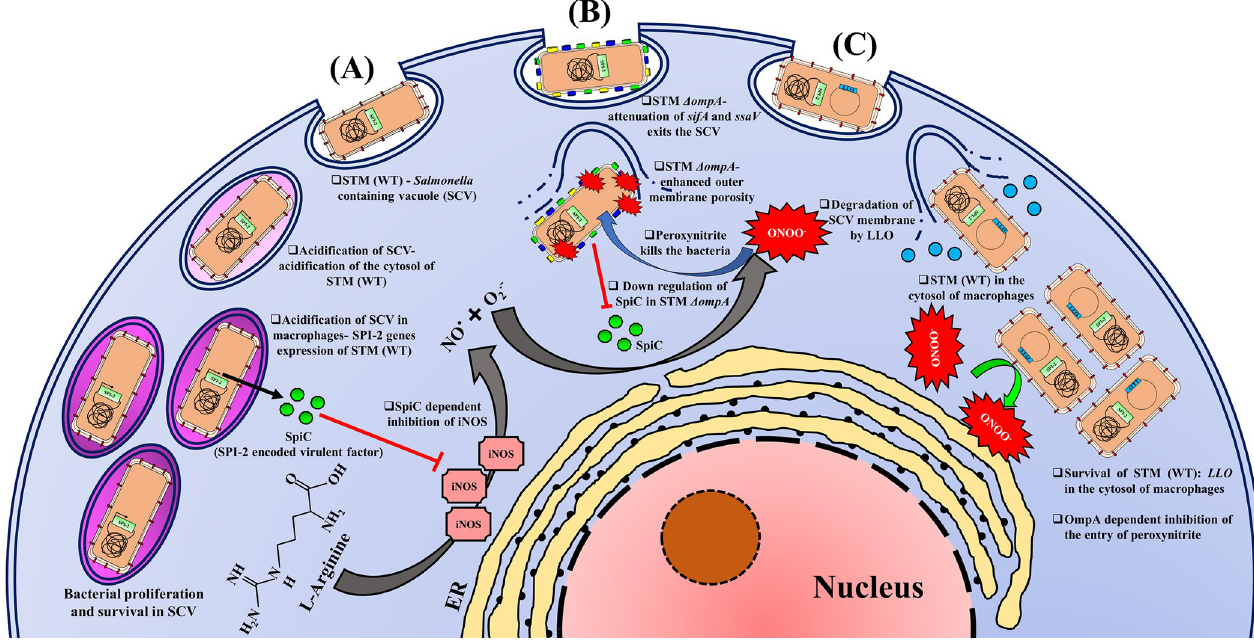
Fig 8. The hypothetical working model of intracellular survival of STM (WT), STM Δ ompA , and STM (WT): LLO . The hypothetical model depicts the fate of (A) STM (WT), (B) STM Δ ompA , and (C) STM (WT): LLO inside the murine macrophages. (A) STM (WT) staying inside the acidic SCV can proliferate efficiently by suppressing the activity of iNOS by SPI-2 encoded virulent factors SpiC. The acidification of the cytosol of wild-type bacteria due to the acidic pH of SCV triggers the expression of SPI-2 genes. (B) STM Δ ompA , deficient in expressing SPI-2 effector genes sifA and ssaV , comes into the cytosol of macrophages after disrupting the SCV. It is unable to produce SpiC and cannot suppress the activity of iNOS. The enhanced outer membrane permeability of the cytosolic population of STM Δ ompA due to the upregulation of ompF makes them vulnerable to RNI. (C) STM (WT): LLO exits the SCV by expressing LLO. Unlike STM (WT), the cytosolic niche of STM (WT): LLO cannot produce SpiC. It can protect itself from RNI by reducing its outer membrane permeability by expressing ompA and surviving efficiently in the